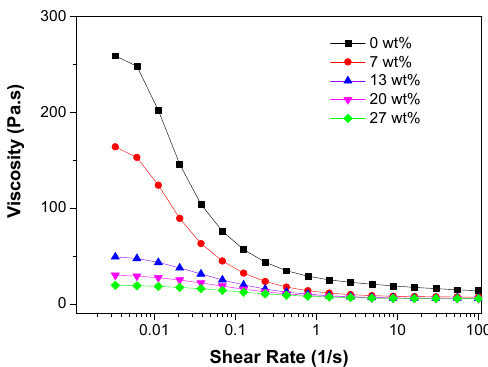
Processes 2019 , 7 , x FOR PEER REVIEW